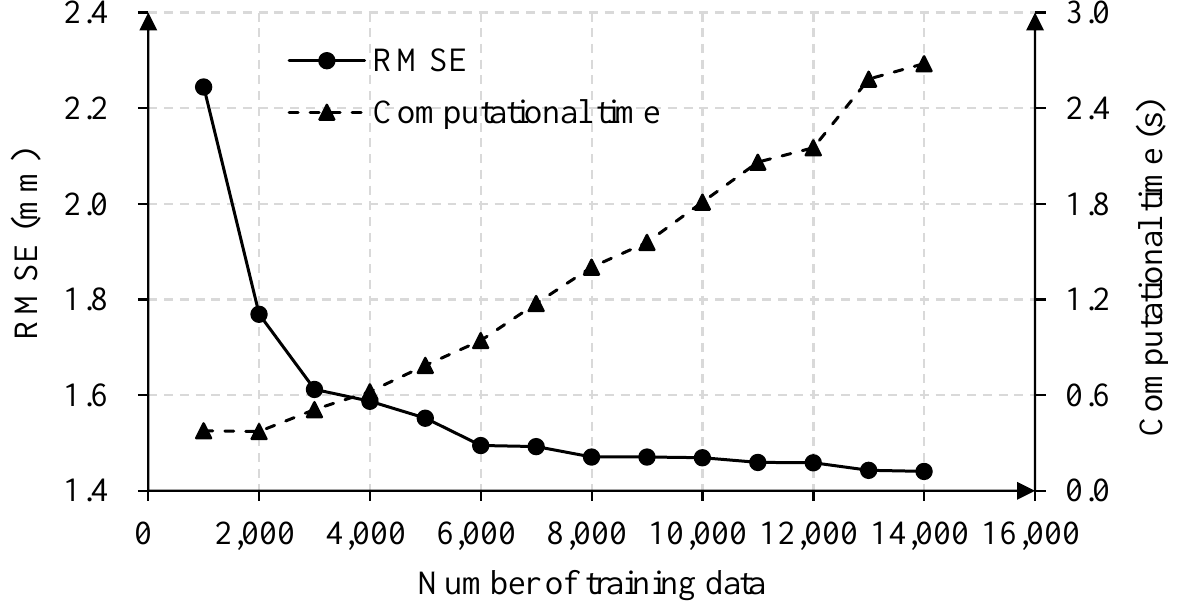
Figure 9. Impact of the size of training dataset on prediction accuracy.